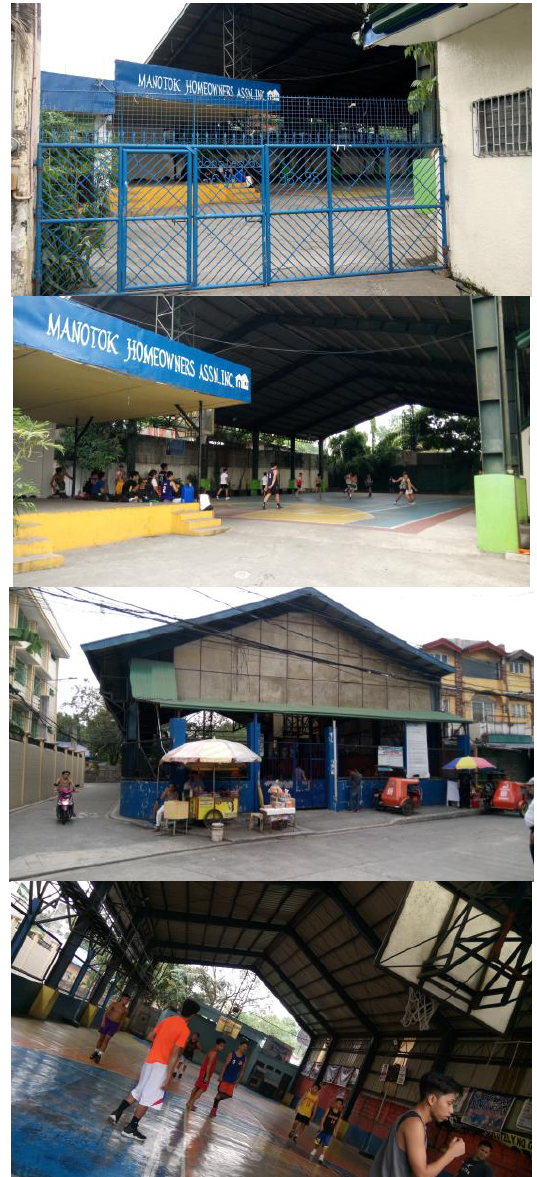
Figure 3. Identified ECs: Manotok Subdivision Covered Court, Marangal Street, Brgy. Baesa, Quezon City (upper two photos); Mendoza Village Covered